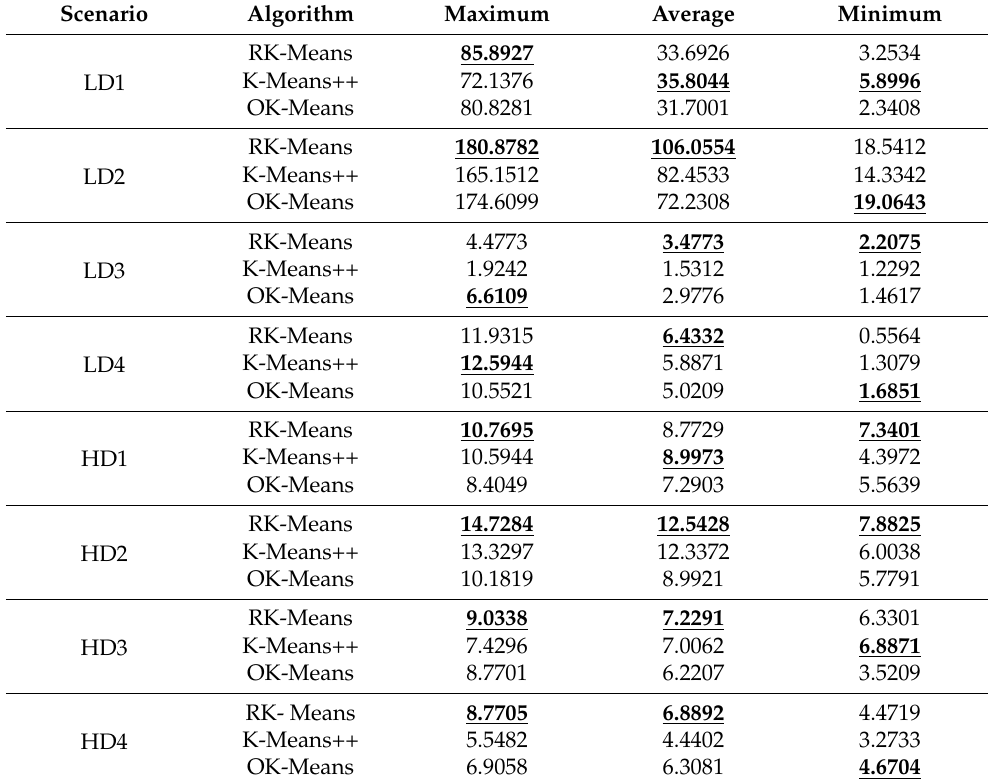
Table 10. DI numerical